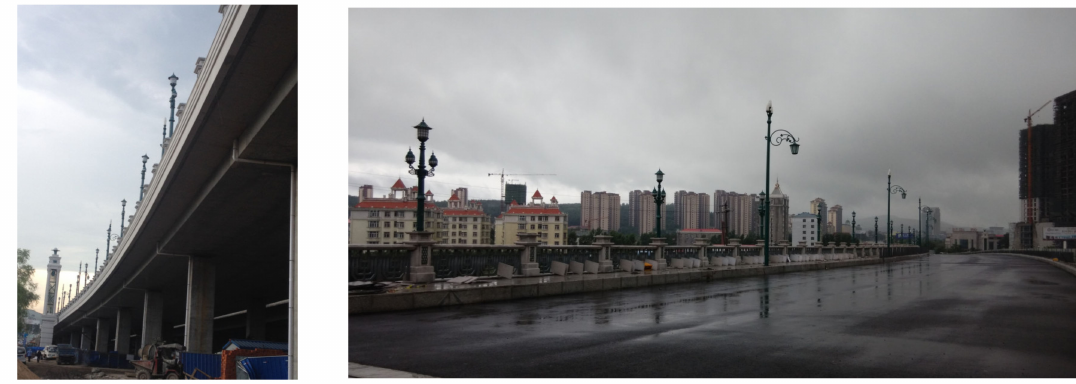
Figure 9. Photograph of the Xinwohong